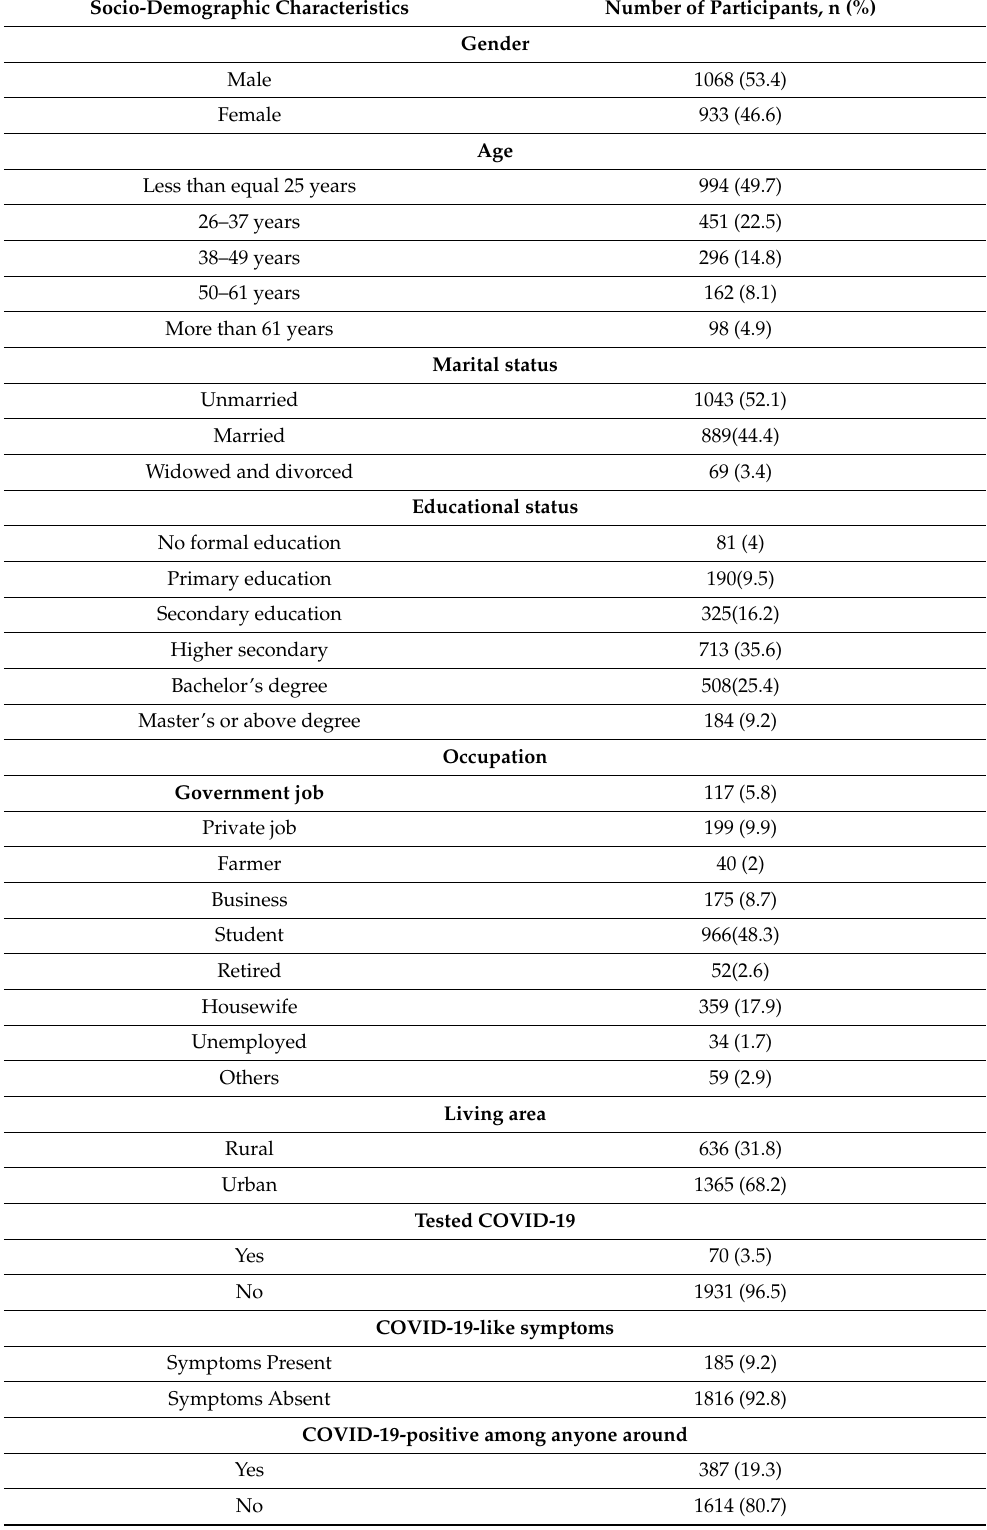
Table 2. Socio-demographic distribution and health-related information of the respondents (n =